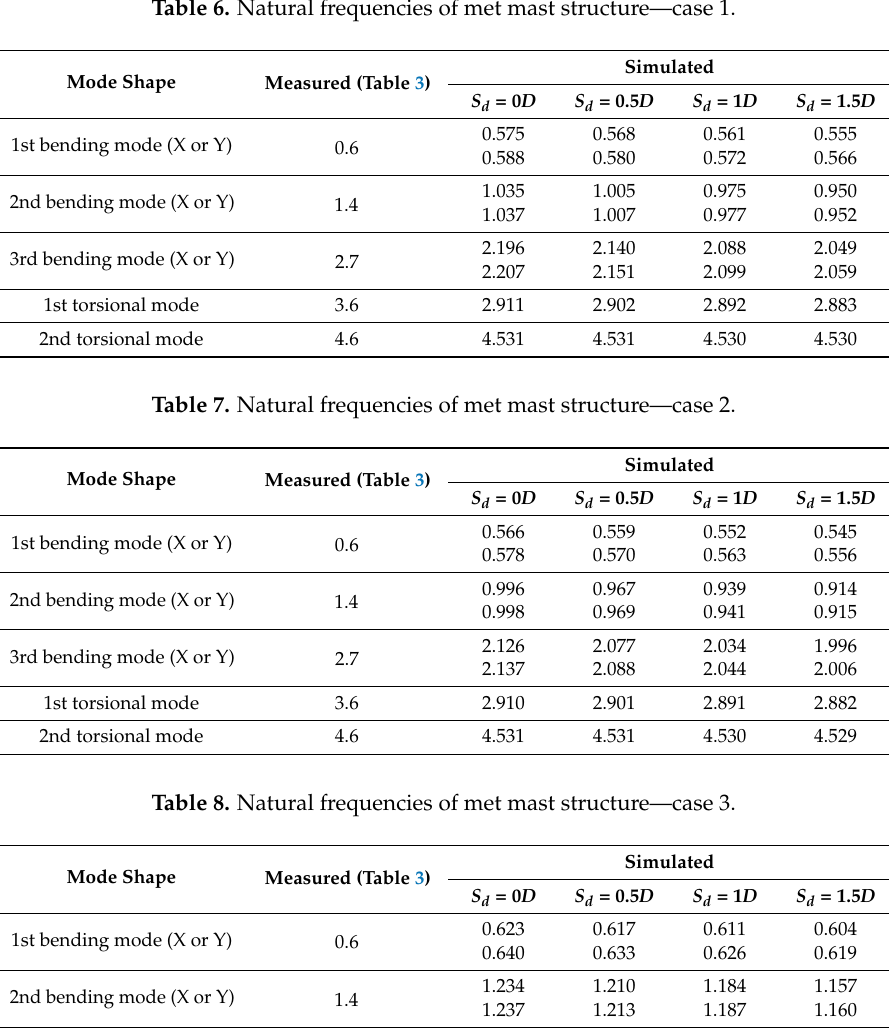
Table 6. Natural frequencies of met mast structure—case 1.